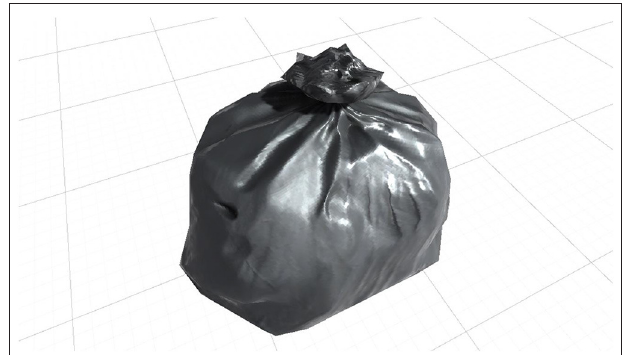
FIGURE 1 | Augmented reality plastic bag.